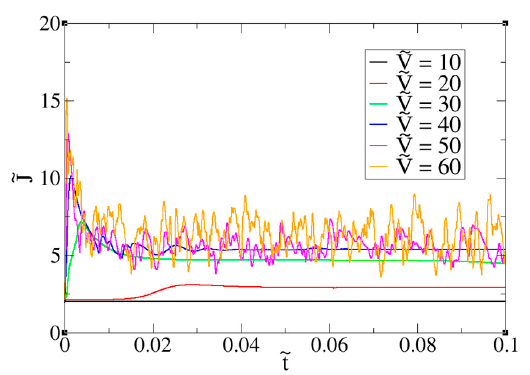
Figure 16. Baseline 2-D case. Area-averaged current density for the wavy membrane with 𝐴 = 0.01 μm and 𝜆 = 15 μm .